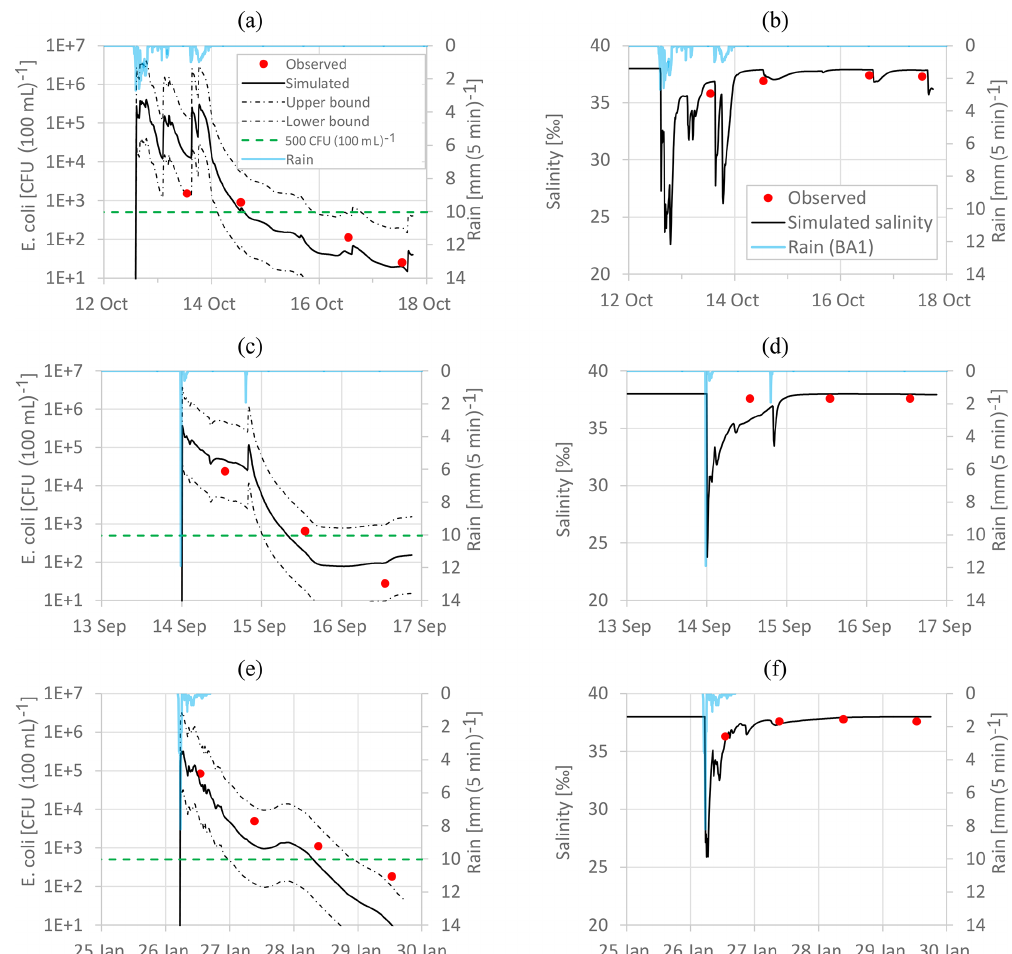
Figure 7. Near-shore simulated and observed E. coli concentrations (a, c, e) and salinity (b, d, f) for the calibration and validation events.